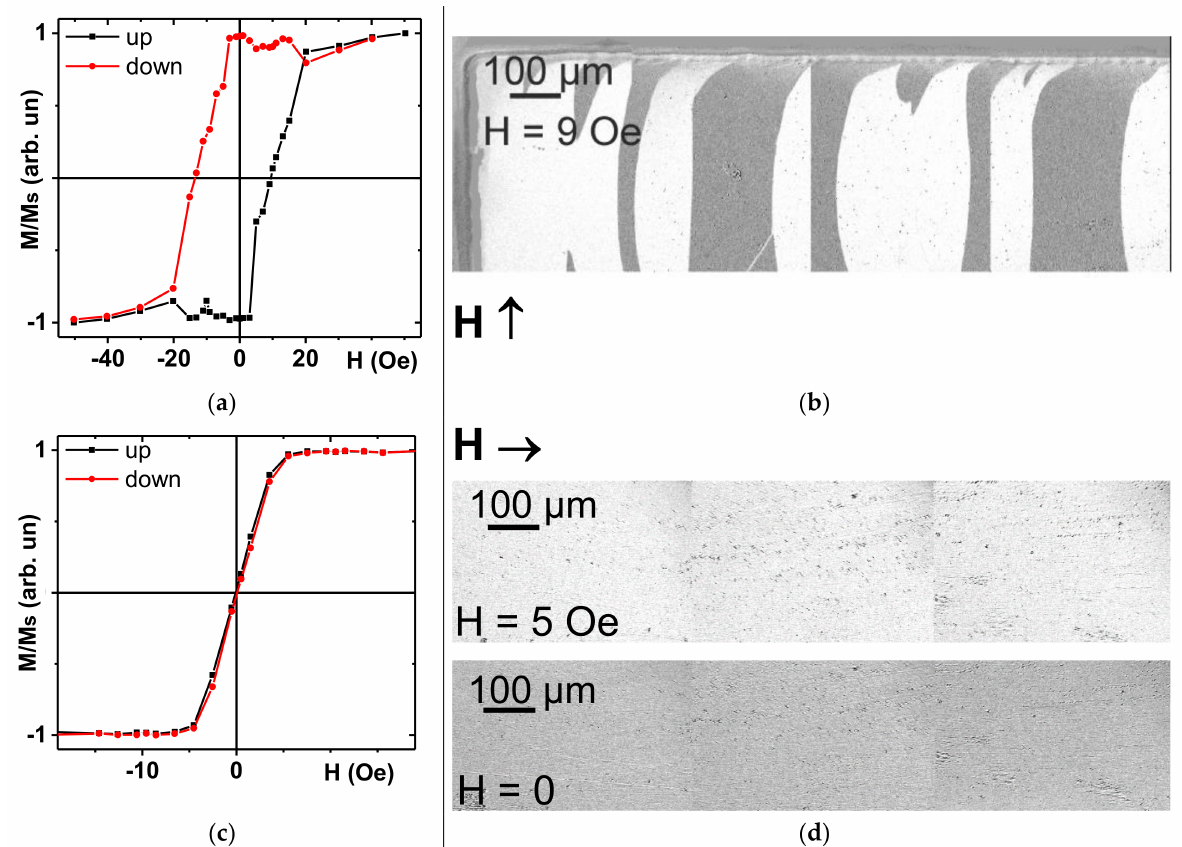
Figure 3. Magnetic hysteresis loops and selected examples of magnetic domain structures of MI element measured by Kerr–microscopy. ( a , b ) Along the short side of the MI element (EMA) or ( c , d ) long side of MI element (EMA). Surface magnetic domain images for the MI element: magnetic field of 9 Oe (coercive force) applied along the EMA ( b ); magnetic field of 5 Oe (approaching the anisotropy field) or close to zero applied along the HMA.